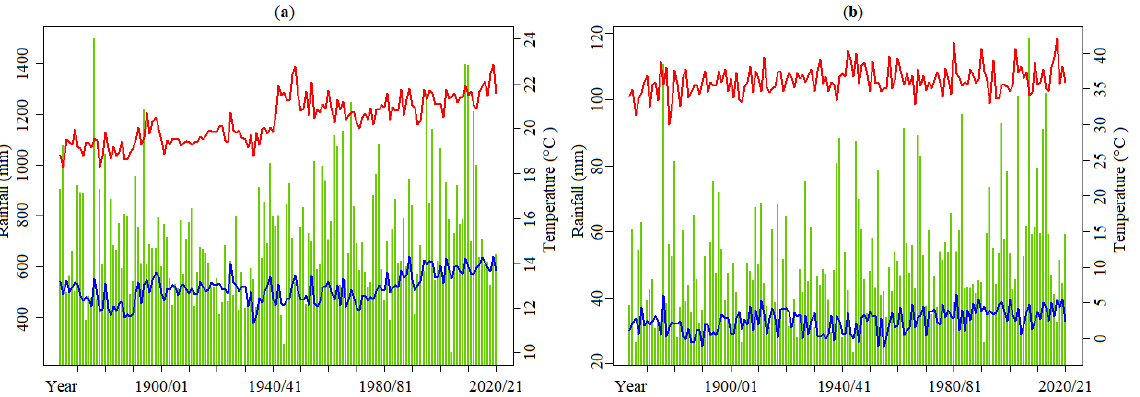
Figure 2. From 1864/65 to 2020/21 at the Lisboa-Geofísico station. Annual series of: ( a ) rainfall (green bars), average Tmin (blue line), average Tmax (red line); and of ( b ) maximum daily rainfall (green bars), minimum daily Tmin (blue line), and maximum daily Tmax (red